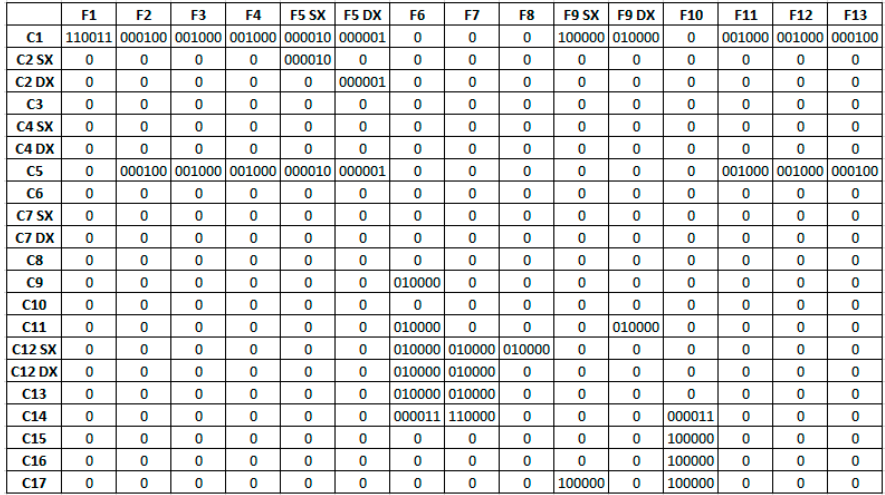
Figure 16. FCM (fasteners components matrix).